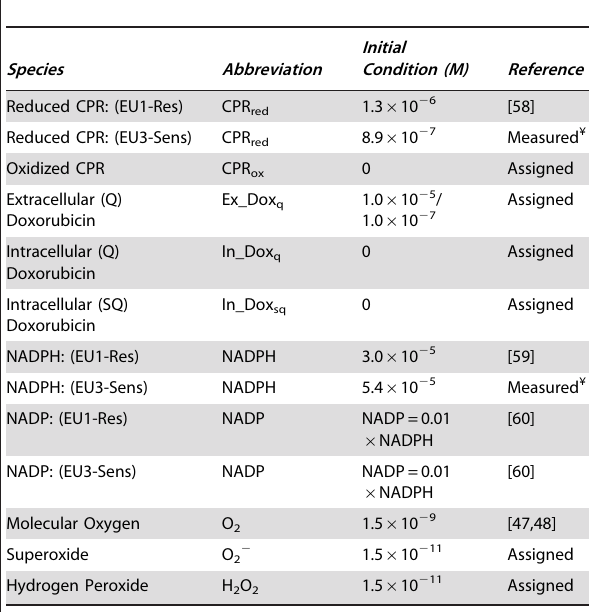
Table 3. Initial concentration values for the species utilized in the in vivo Dox